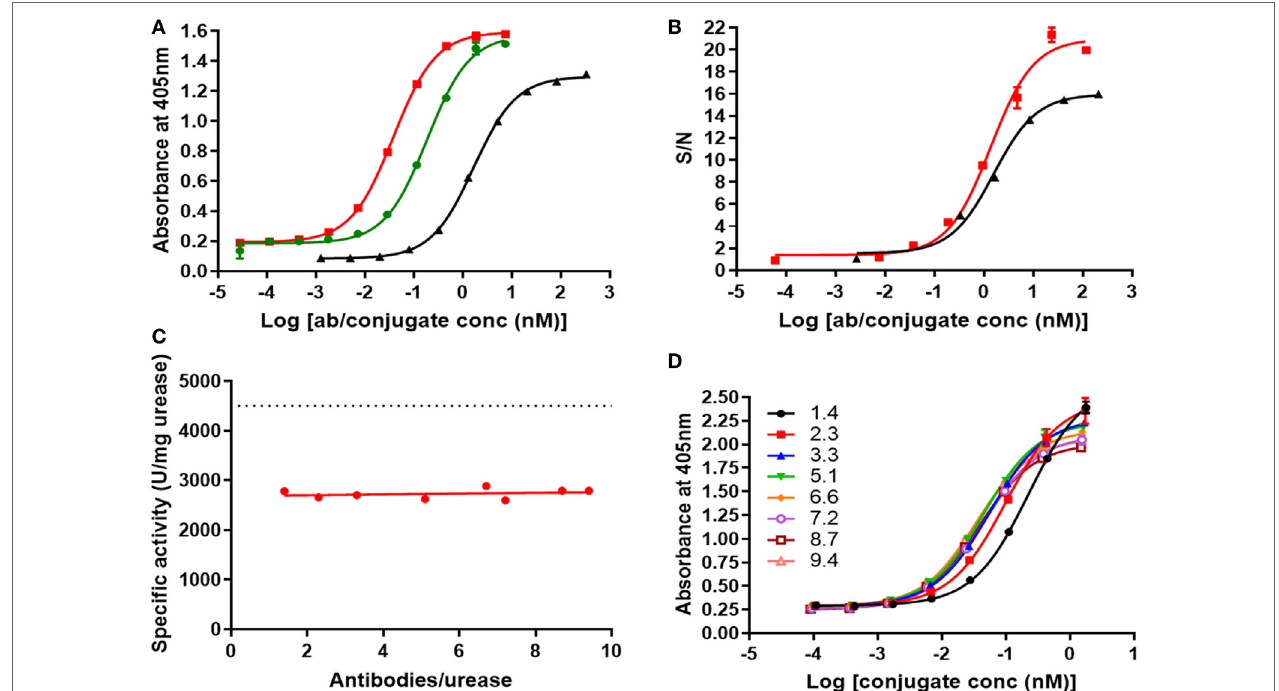
FigUre 6 | (a) ELISA of biotin-V21H4 (black), V21H1-DOS47 (green), and V21H4-DOS47 (red) binding to recombinant VEGFR2. Results shown are representative of two to five experiments performed for each sample and are presented as the means and SE of samples tested in triplicate. (B) Binding of biotin-V21H4 (black) and V21H4-DOS47 (red) to VEGFR2 expressed by 293/KDR cells. Binding was quantified by flow cytometry. Results shown are representative of two to three experiments performed for each sample and are presented as the means and SE of samples tested in duplicate. (c) Urease enzyme activity of V21H4-DOS47 at different antibody/urease conjugation ratios (CRs). The dotted line represents unconjugated urease activity. (D) ELISA of V21H4-DOS47 with different antibody– urease CRs binding to recombinant VEGFR2/Fc. Results shown are representative of two experiments performed for each sample and are presented as the means and SE of samples tested in